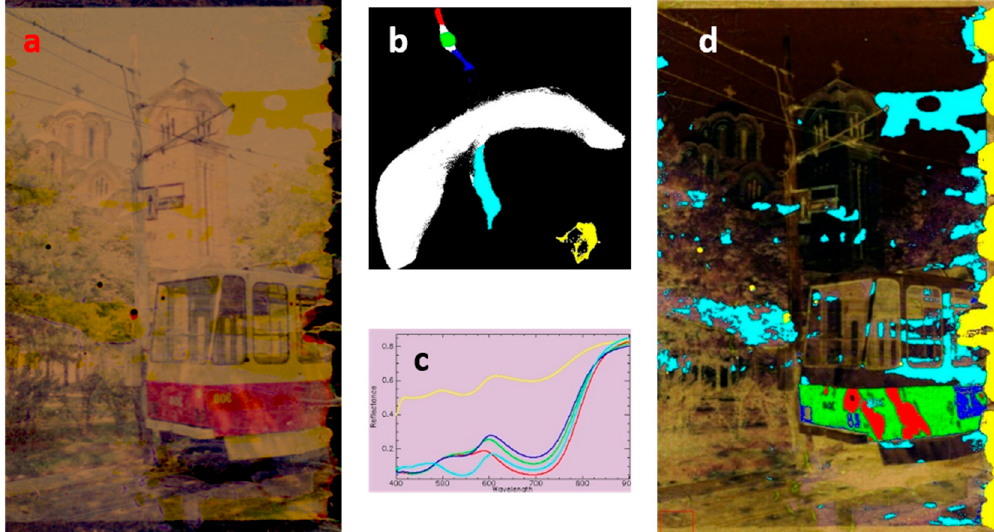
Figure 1. (a ) sRGB image of the investigated frame; ( b ) UMAP image with the selected five sub-sets of fairly distinct pixels (highlighted in red, green, blue, cyan, and yellow); ( c ) spectra extracted from the data-cube representative of the UMAP five classes reported in ( b ); ( d ) displacement of the UMAP five classes on the HSI reconstructed visible image.